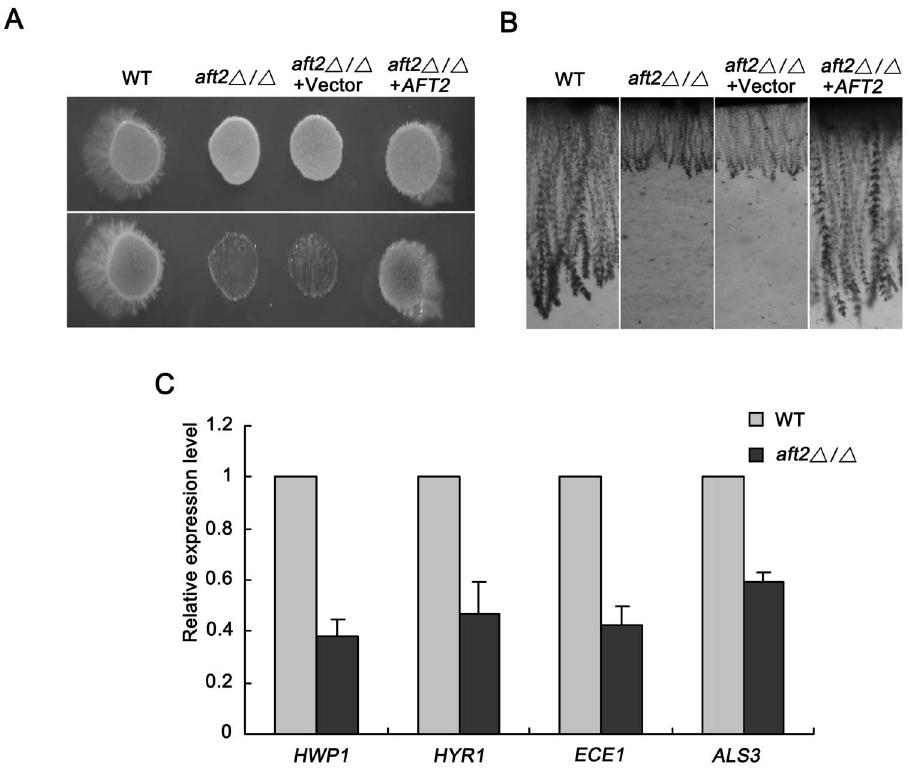
Figure 5. Deletion of AFT2 affects the ability of invasive growth in C.albicans . Wild-type, aft2 D / D mutant, aft2 D / D + Vector (NKF47) and AFT2 complemented strains (NKF46) were resuspended to OD 600 < 0.1. 5 m l suspension was respectively spotted onto solid M199 medium (pH 7.4) and Spider medium. (A) The Spider plates were photographed before and after wash. Analogous results were observed for growth on two different solid medium. (B) The agar medium was cut into 1-mm thick slices and the invasion was examined under the microscope. (C) Cells growing in solid Spider medium for 5 days were harvested by mechanical disruption in cold PBS buffer and used for RNA extraction. Expression analyses of selected hypha- specific genes were assessed by quantitative real-time PCR, and data are representative of three independent experiments.